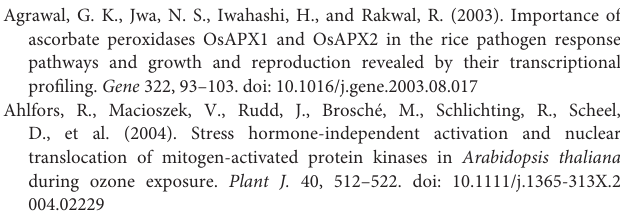
Supplementary Figure 6 | Quantitative real-time RT-PCR analysis of time-course expression of defense-response genes OsPR-1b , OsPAL1 , OsAPX1 , and OsAPX2 in wild-type (WT) rice (cultivar DJ), (cid:49) Osmek2 #2, and 35S: OsMEK2 #4 plants during Magnaporthe oryzae 007 infection. Leaf sheaths of wild-type (cultivar DJ), (cid:49) Osmek2 #2, and 35S: OsMEK2 #4 rice plants were sampled at different time points after inoculation, followed by total RNA extraction. Relative gene expression levels of defense-responsive genes OsPR-1b (Os01g28450), OsPAL1 (Os04g43760), OsAPX1 ( Os0.g17690 ), and OsAPX2 ( Os07g49400 ) at each time point were obtained by normalizing the gene expression with respect to expression of the internal control 18S rRNA gene. Data represent the means ± SD from three independent experiments. Different letters above the bars indicate significantly different means ( P < 0.05) as analyzed by Fisher’s protected LSD test. Supplementary Figure 7 | Images of Prussian blue-stained and DAB-stained leaf sheath cells of wild-type (WT) rice (cultivar DJ) at different time points after erastin treatment. Rice DJ leaf sheaths were treated with mock (water) and 10 µ M erastin. Images were taken using a fluorescence microscope (Zeiss equipped with Axioplan 2). Prussian blue and DAB staining in erastin-treated rice leaf sheaths did not detect ferric ion and ROS accumulation, respectively, at different time points after treatment. Experiments were repeated three times with similar results. hpt, hours post-treatment. Scale bars = 20 µ m. Supplementary Figure 8 | Nucleotide sequences and deduced amino acid sequences of rice MAP kinase 1 (OsMPK1) genomic DNA. Small letters represent nucleotide sequences of exons and introns. Capital letters represent deduced amino acid sequences of exons. Initiation and termination codons of the OsMPK1 coding region are represented by asterisks. Numbers at the right refer to nucleotide and amino acid (in parentheses) residue positions in the respective sequence. Supplementary Figure 9 | Amino acid sequence alignment of rice MAP kinase 1 (OsMPK1) with other plant MPKs. Amino acid sequence of OsMPK1 was aligned with plant MAP kinases using CLUSTAL OMEGA (EMBL-EBI). Accession numbers of the aligned plant MPKs are OsMPK1 (Os06g06090), OsMPK6 (Os10g38950), AtMPK6 (At2g43790), AtMPK3 (At3g45640), AtMPK4 (At4g01370), AtMPK11 (At1g01560), NbMKK1 (BAE95414), LeMPK1 (NP_001234011), LeMPK2 (NP_001234355), LeMPK3 (NP_001234360), and ZmMPK5 (PW05027). Supplementary Figure 10 | Phylogenetic tree of rice MAP kinase 1 (OsMPK1) with plant MPKs. Accession numbers: MPKs are OsMPK1 (Os06g06090), OsMPK6 (Os10g38950), AtMPK6 (At2g43790), AtMPK3 (At3g45640), AtMPK4 (At4g01370), AtMPK11 (At1g01560), NbMKK1 (BAE95414), LeMPK1 (NP_001234011), LeMPK2 (NP_001234355), LeMPK3 (NP_001234360), and ZmMPK5 (PW05027). Supplementary Figure 11 | Transcriptional analysis of OsMPK1 expression in leaf sheath epidermal cells of wild-type (WT) rice (cultivar NB) and 35S: OsMPK1 plants using qRT-PCR. Relative gene expression of OsMPK1 was obtained by normalizing with respect to the expression of the internal control OsUbiquitin gene. Data represent the means ± SD from three independent experiments. Asterisks indicate statistically significant differences (Student’s t -test, P < 0.01). Supplementary Table 1 | Primers used in this